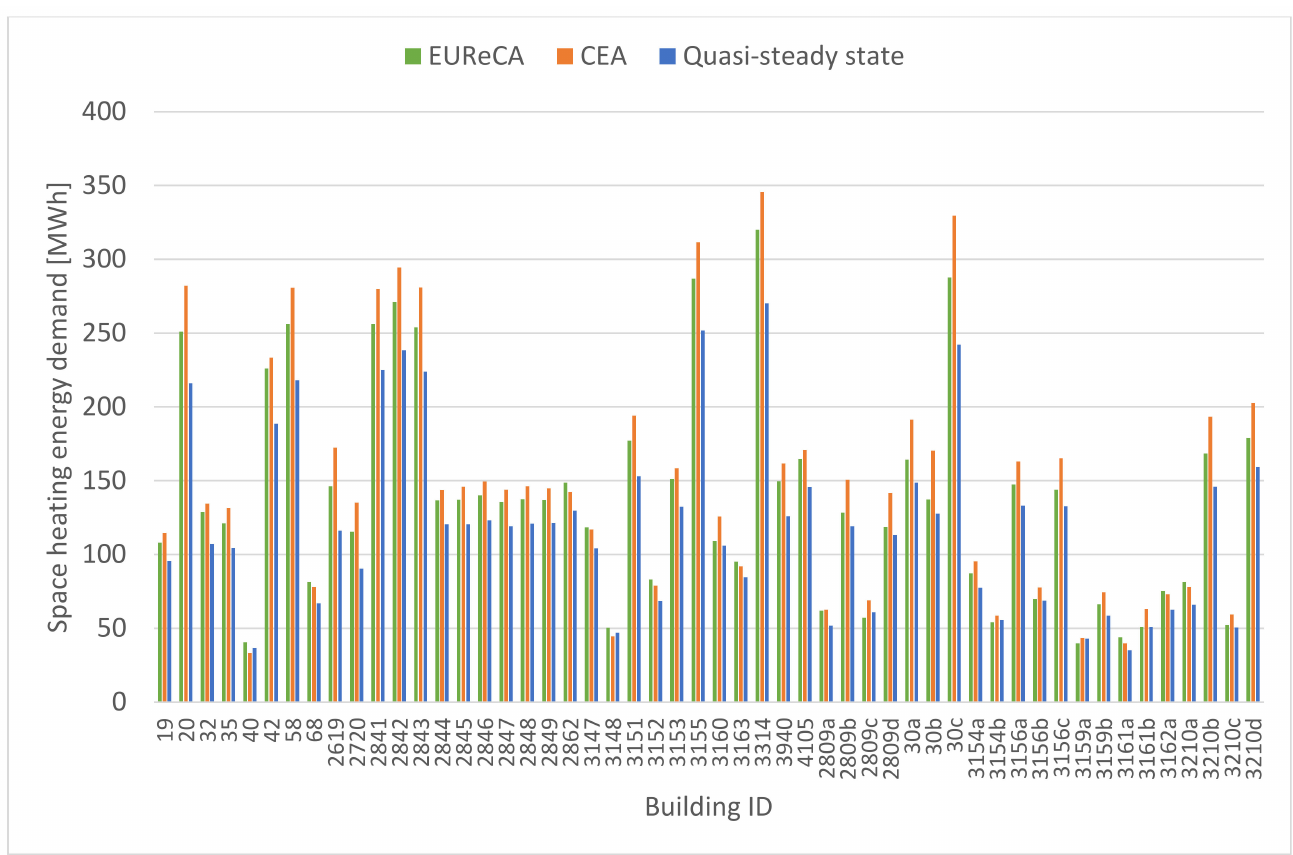
Figure 8. Evaluation of the space heating energy demand in the heating period considering the contribution of internal